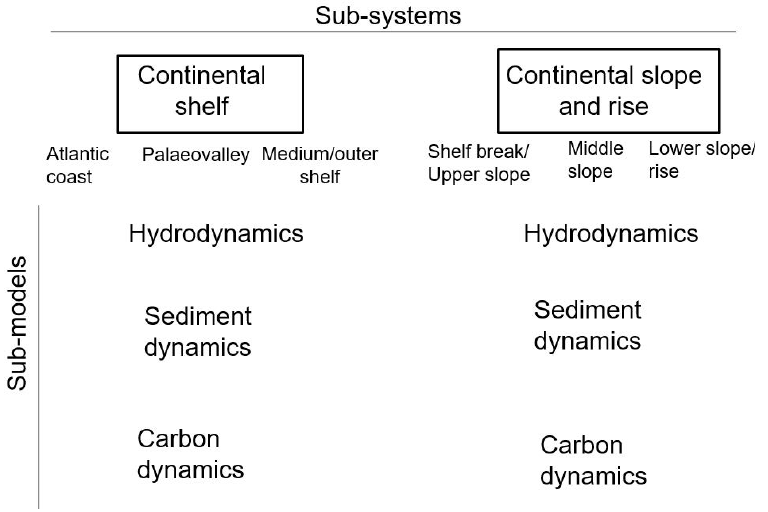
Figure 5. Schematic representation of the structure of conceptual models. Each sub-system (continental shelf and continental slope/rise) is described by three sub-models (hydrodynamics, sediment dynamics, and carbon dynamics). Different sedimentary environments (i.e., Atlantic coast) further characterized each sub-system.